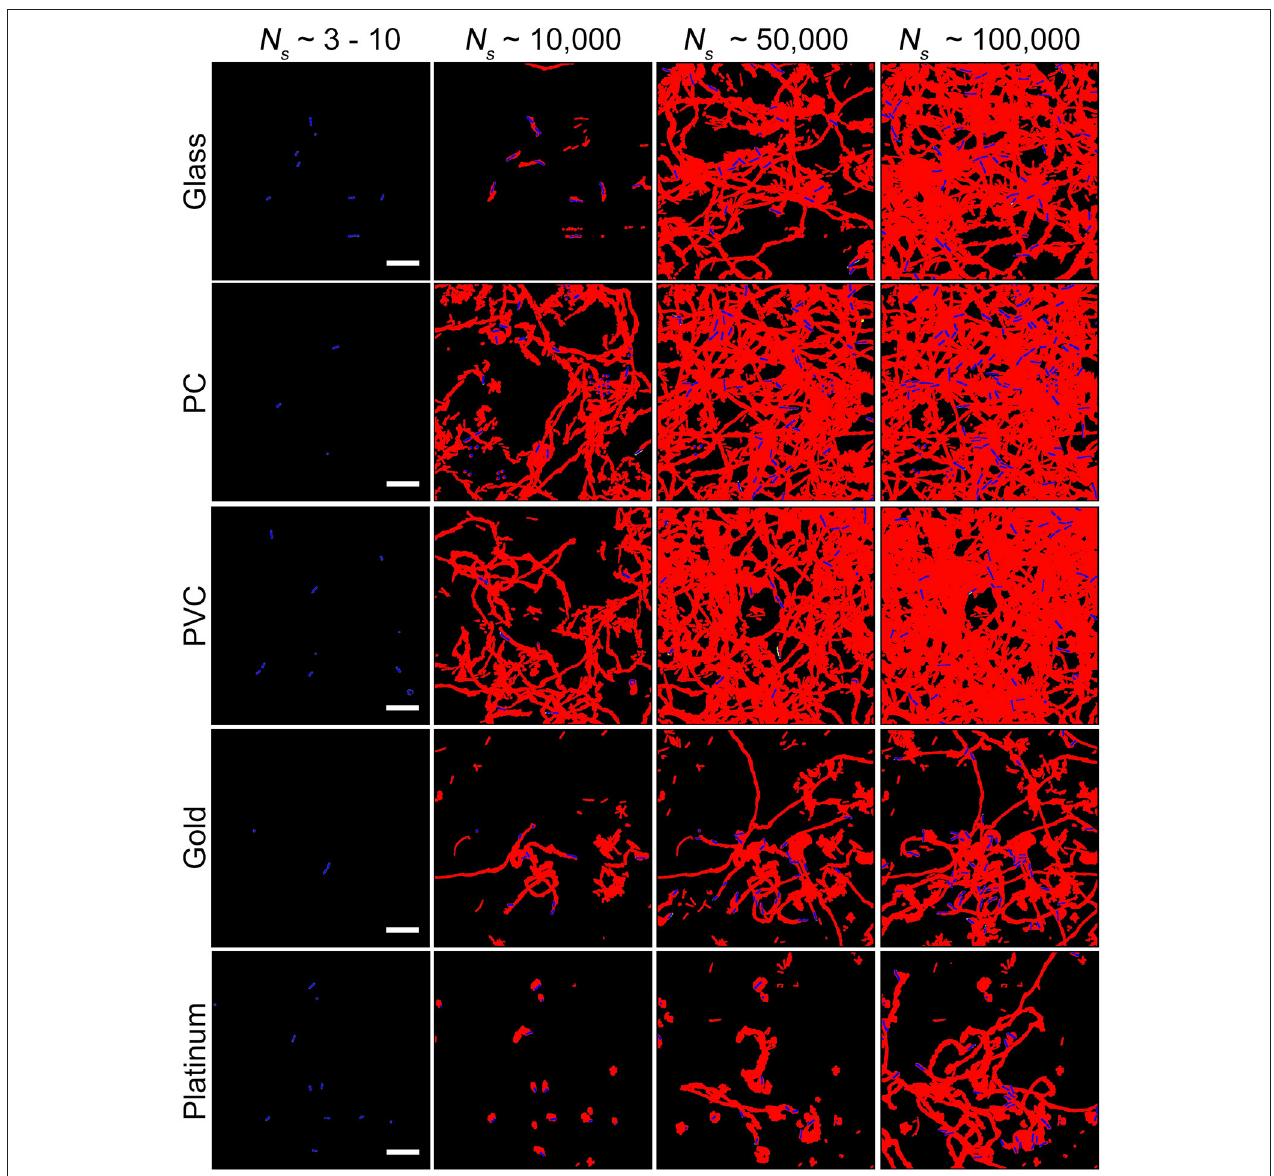
FIGURE 2 | Surface coverages at different total number of bacterial visits N s for the five tested surfaces. Red and black colors represent contaminated (i.e., visited by bacteria) and fresh areas, respectively. Bacteria in the current frame are shown in blue. Scale bars are 10 µ